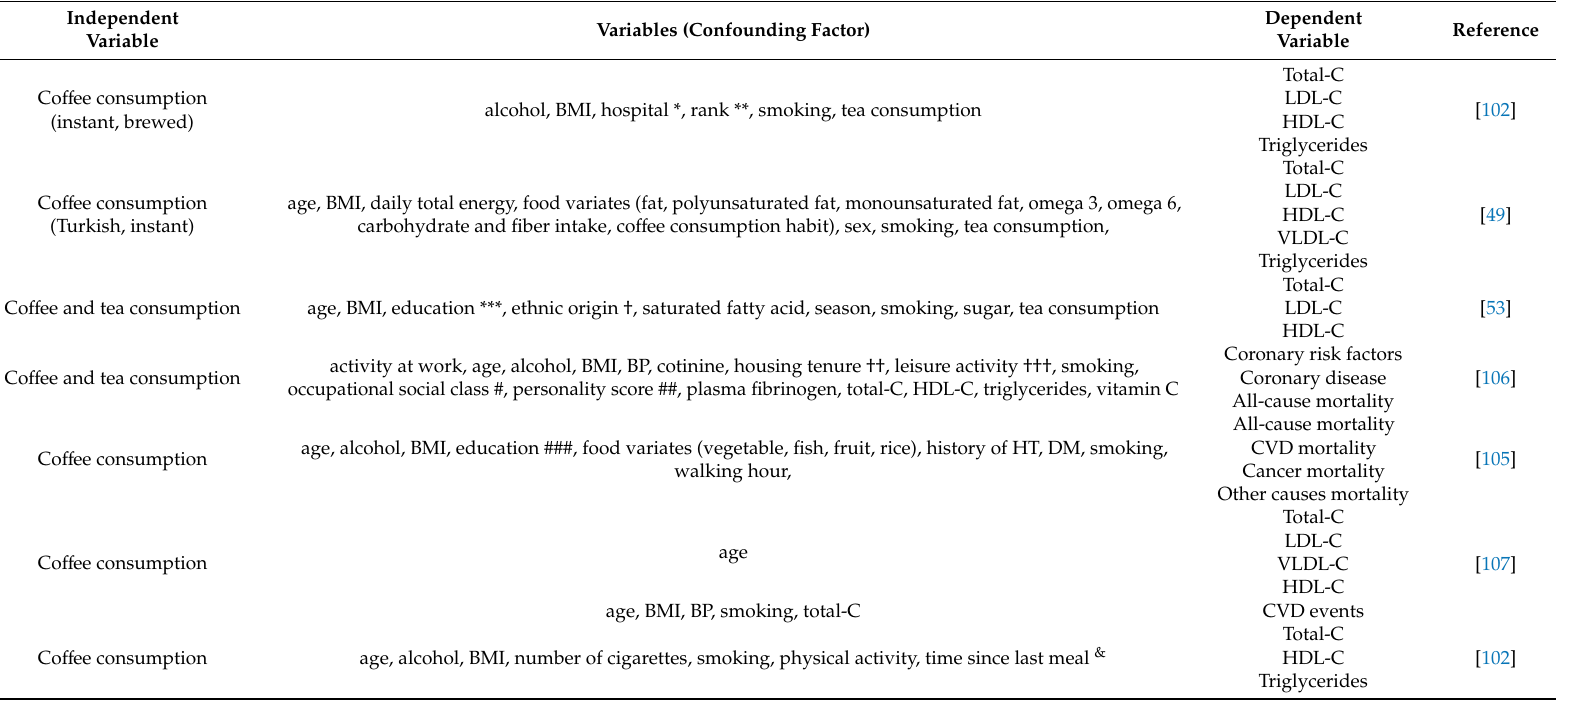
Table 4. Suspected confounding factors influencing the e ff ect of co ff ee consumption on cardiovascular disease-related dependent variables in epidemiological clinical